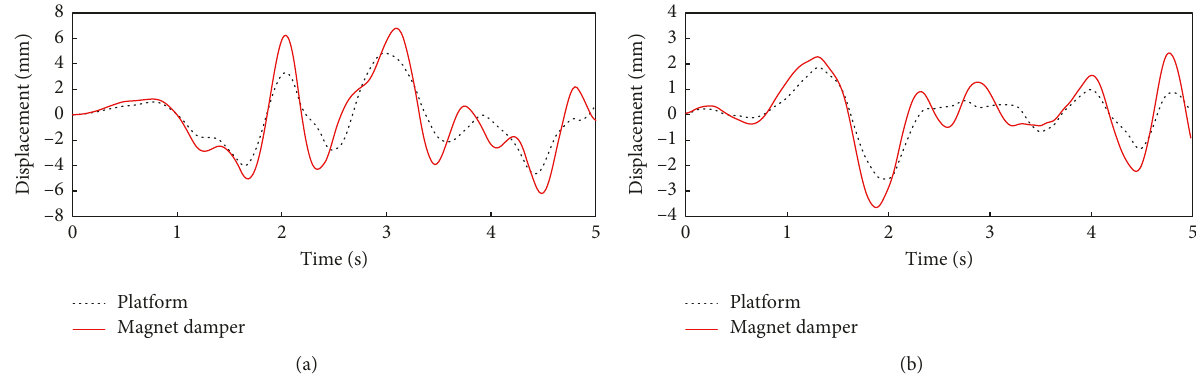
Figure 16: Displacement responses of platform and magnet damper under two seismic waves. Displacement responses for the (a) El-Centro NS seismic wave and (b) Taft EW seismic